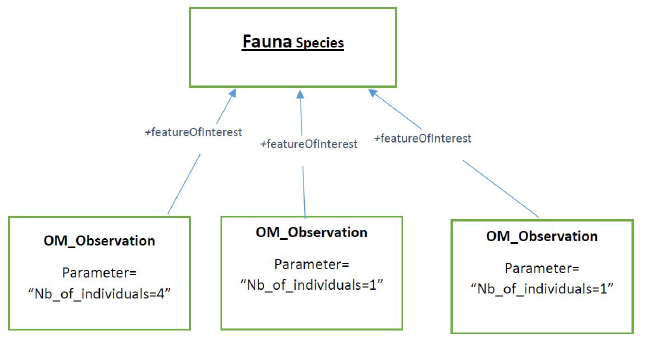
Figure 7. Running example: UML mapping on the geographic area.